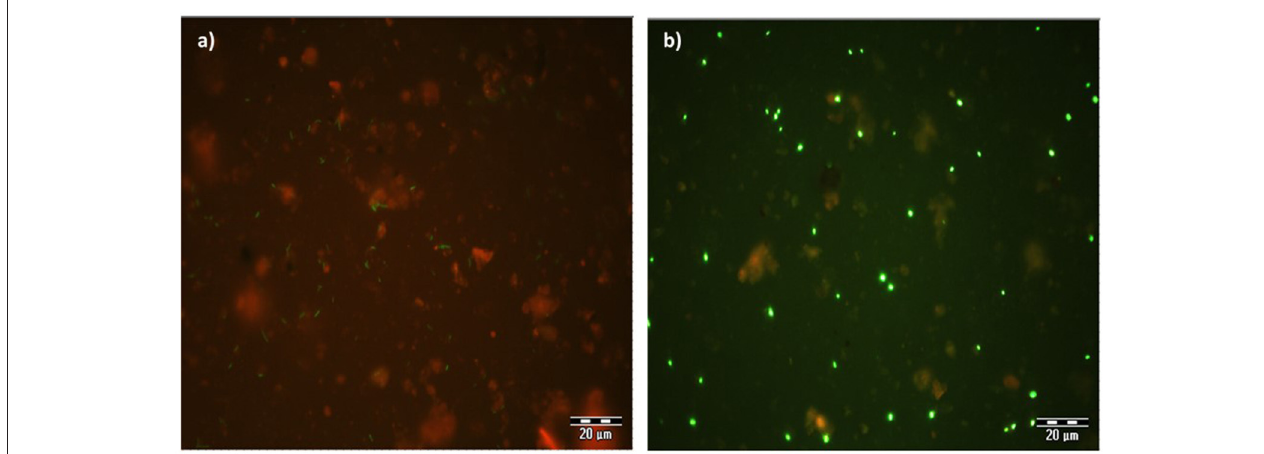
FIGURE 4 | An example of microscopic images GFP-tagged (a) and CARD-FISH stained (b) Bacillus subtilis cells in soil filter sections under double excitation filter (465–505 and 564–892nm). Scale bar 20 µ m.